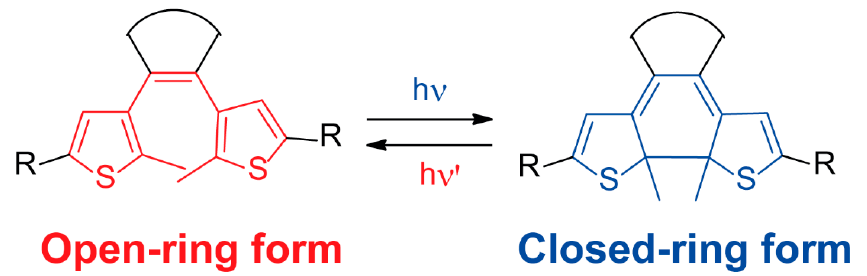
Figure 5. Photoisomerization of a diarylethene compound showing the open ring (shown in red) and closed ring (shown in blue) forms.